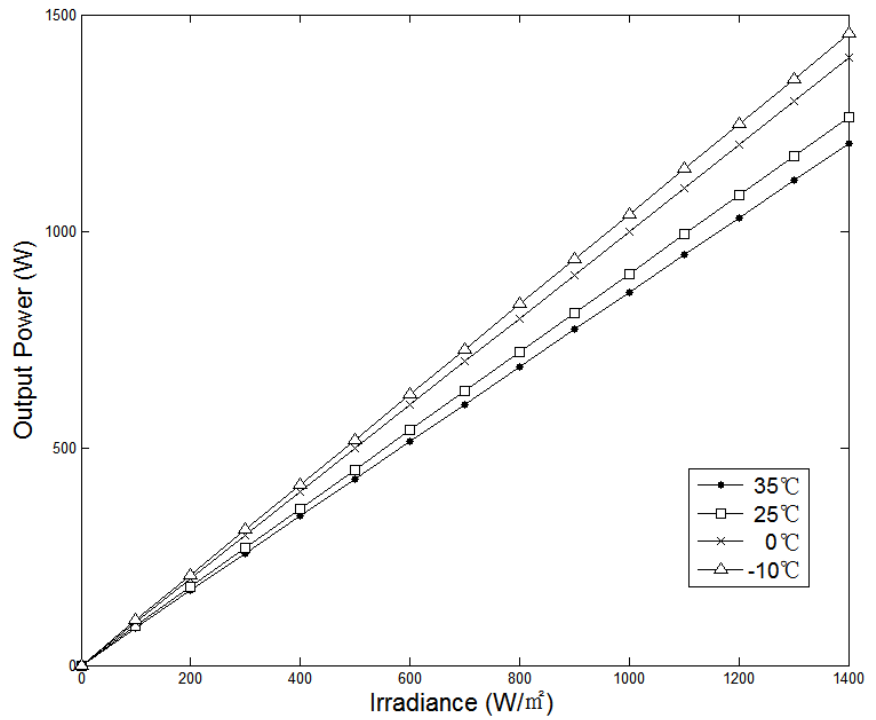
The output power characteristics of a PV array under different irradiance intensities and